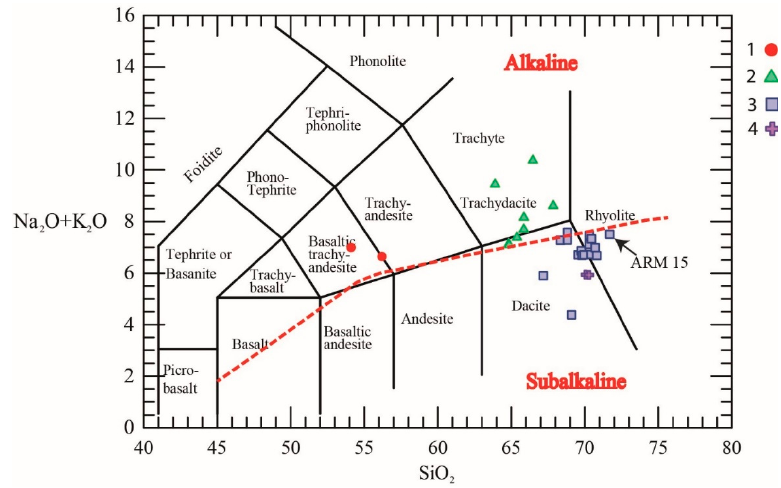
Minerals 2021 , 11 , x FOR PEER REVIEW Figure 8. Chemical nomenclature of the volcanic rocks of the TSESDAI eruptive complex. Legend: (1) andesites; (2) dacites (Bled Bou Haouza); (3) rhyolitic domes; (4) rhyolitic dike.